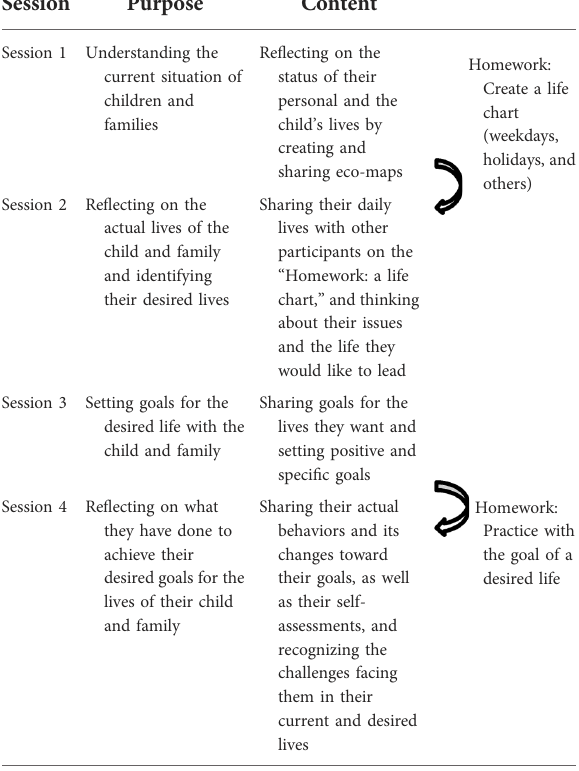
TABLE 1 Purposes and content of the